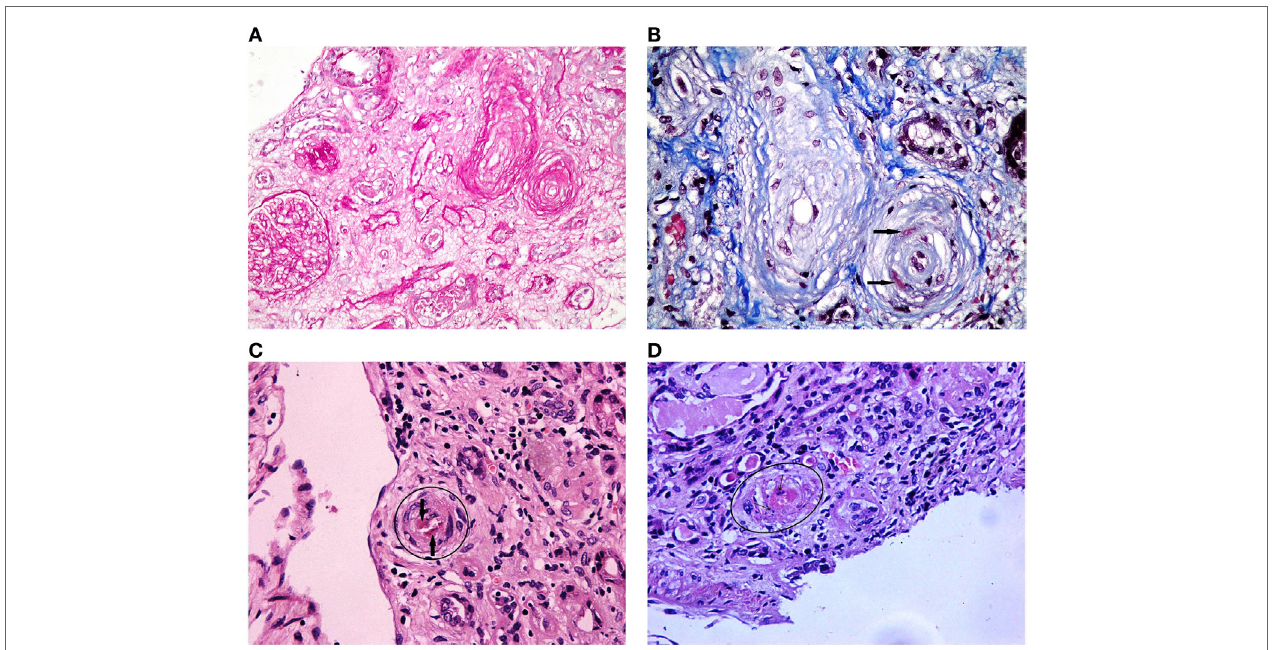
FigURe 1 | Antiphospholipid syndrome nephropathy histologic lesions. (A) Luminal narrowing due to circumferential myointimal thickening of the wall of one arteriole and one interlobular artery. Glomerulus exhibiting ischemic features with wrinkling of the glomerular capillary basement membranes (PAS 200 × ). (B) An interlobular artery and an arteriole showing luminal narrowing due to pale mucoid intimal thickening and myointimal cellular proliferation. Additionally, the arteriole reveals fibrin insudation within the wall (black arrows) (Masson trichrome 400 × ). (C) Arteriole showing luminal thrombus (HE 400 × ). (D) Arteriole showing TMA with platelet-fibrin thrombus occluding the lumen and nuclear debris in the arterial wall (HE 400 ×